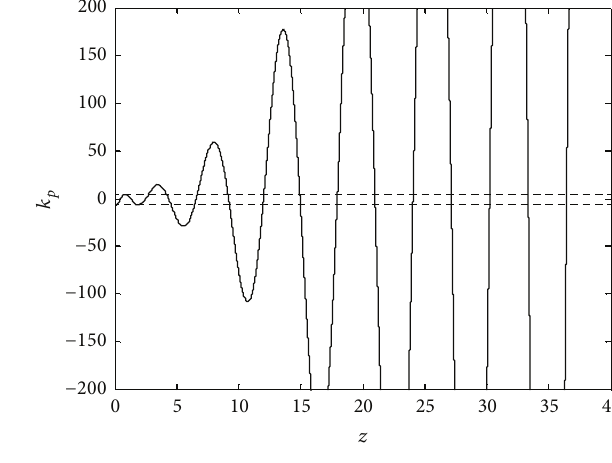
Figure 4: Graph of the function 𝑘 𝑝 .